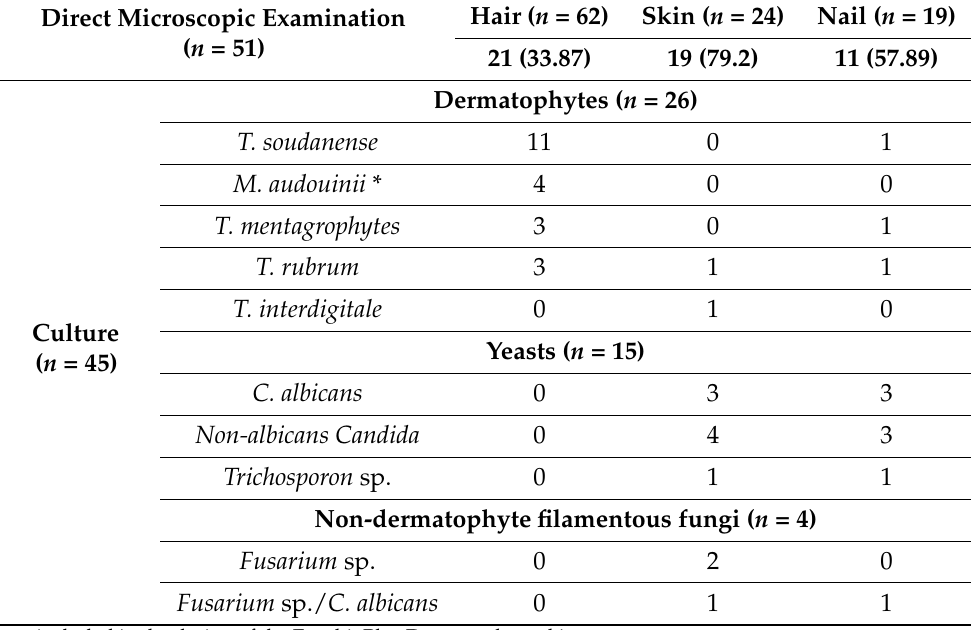
Table 1. Positive results of direct microscopic examination and culture ( n =